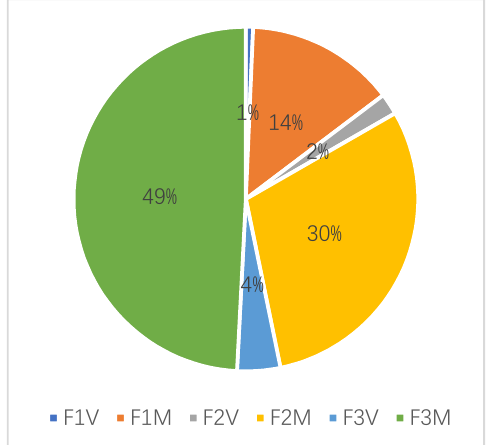
Figure 6. Comparison of mortalities (M) and survival rates (V) during three female stages of P. ziziphi . (F1V: Survived females of stage 1; F1M: Dead females of stage 1; F2V: Surviving females of stage 2; F2M: Dead females of stage 2; F3V: Surviving females of stage 3; F3M: Dead females of stage 3).